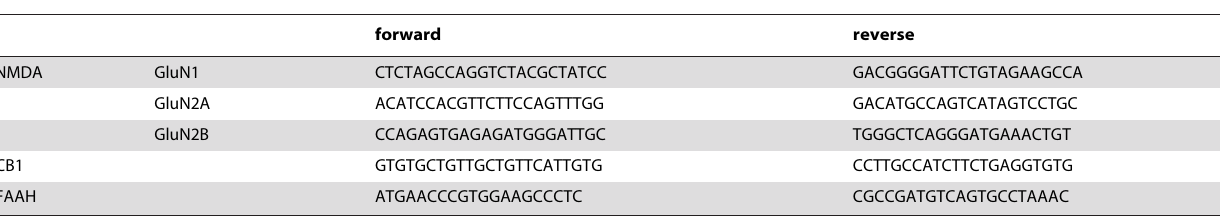
Table 2. Sequences of primers used for quantitative